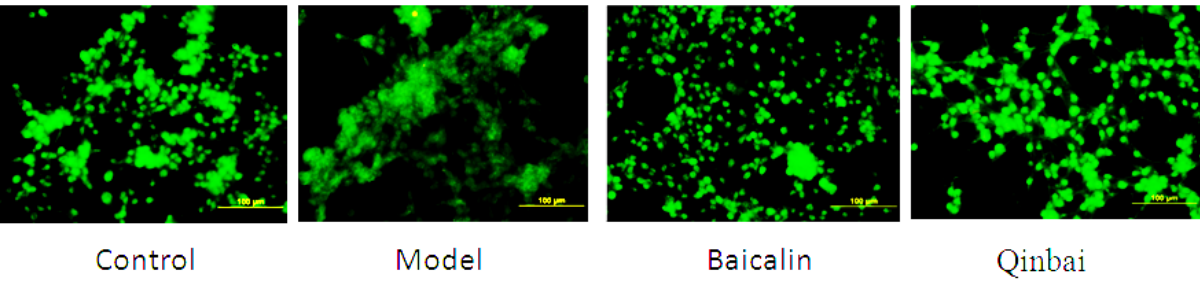
Figure 10. Immunofluorescence was used to analyze EGF protein expression. Experiments were repeated